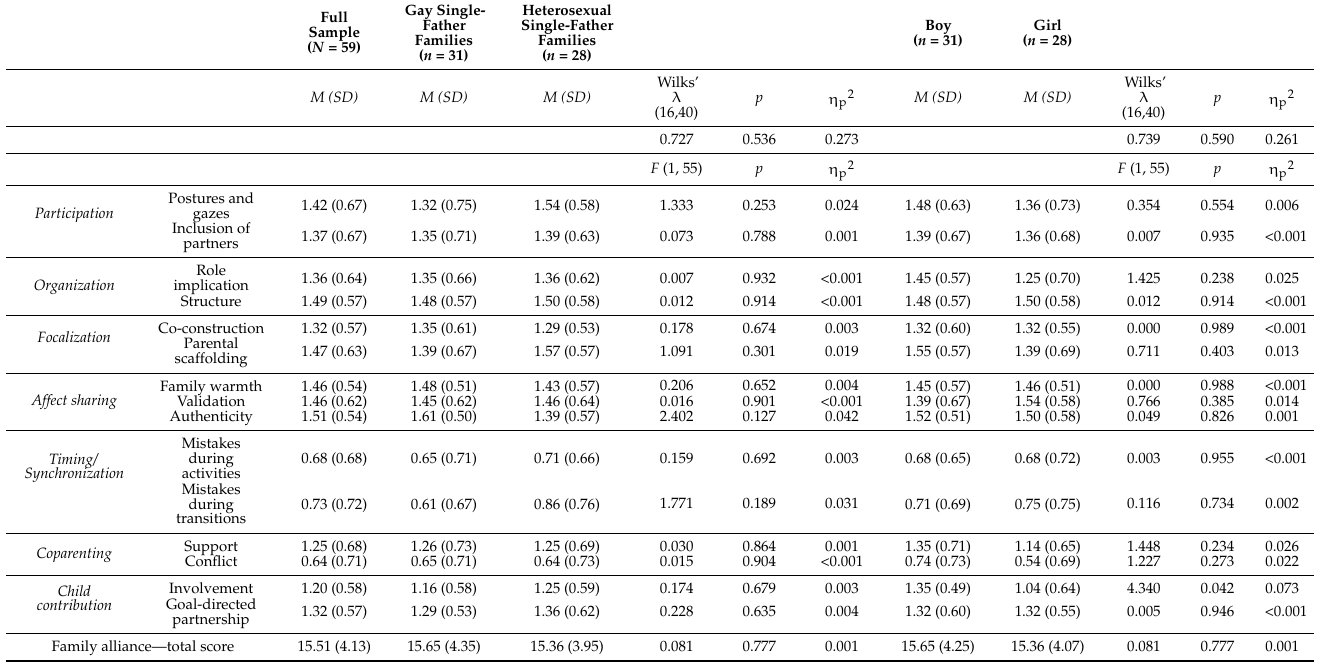
Table 3. Family alliance assessment scale mean scores across family type and child gender ( N =